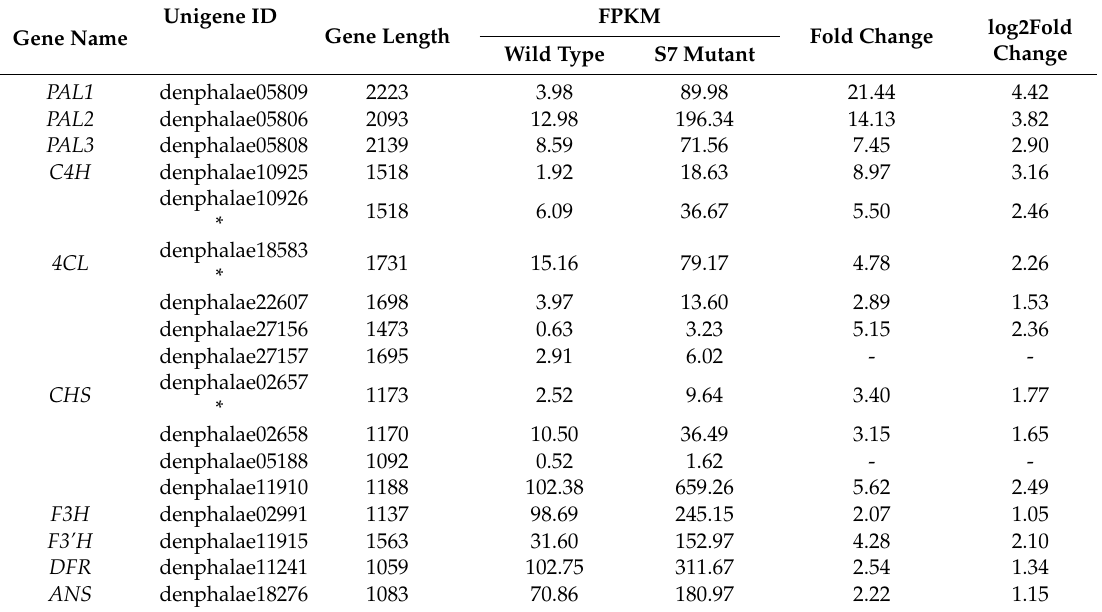
Table 4. Expression profiles of anthocyanin biosynthetic genes.